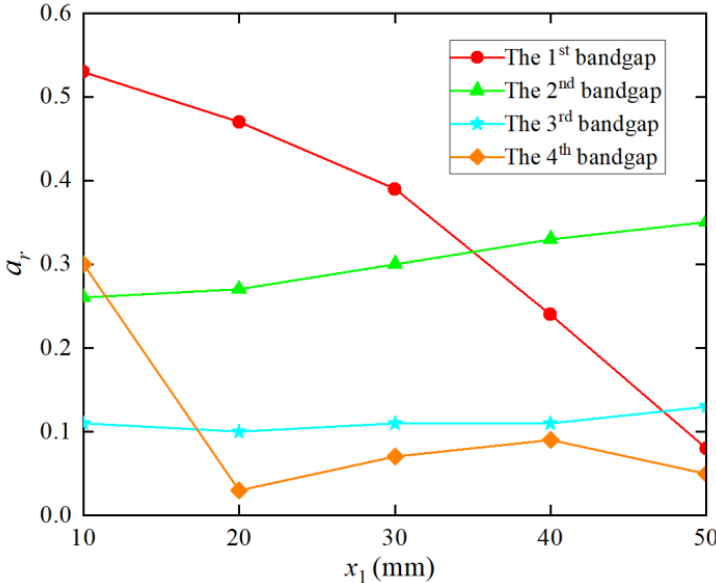
Figure 13. Influences of square hollow side length on the relative bandwidth. The variation trend of the third bandgap is different from those of the first two bandgaps. Specifically, with the gradually increase of x 1 , α r changes slightly around 0.1. For the fourth bandgap, when x 1 is 10 mm, the maximum value is achieved, which is 0.3, and the minimum value of α r is 0.03 when x 1 increases to 20